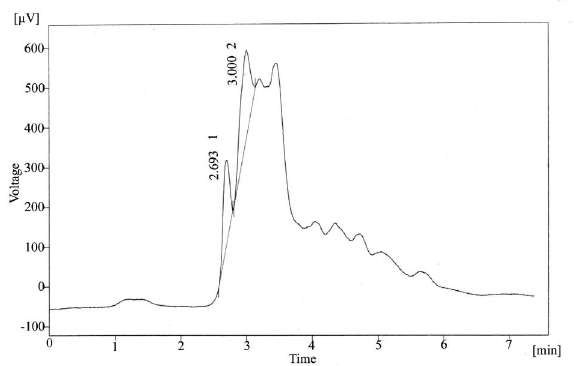
Fig . 2. – HPLC profile of active TLC fraction of Falkenbergia - phase of A. taxiformis.